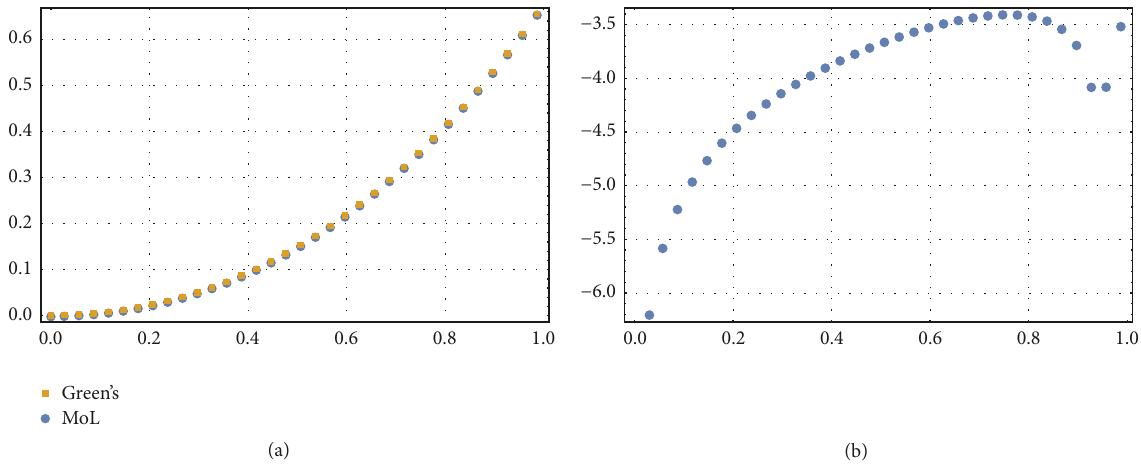
Figure 10: Discrete plot of 𝑤 and 𝑤 MoL (a) and Er (b) against 𝑡 ∈ [0,1] for 𝑓(𝑡) = exp (𝑡) : hyperbolic potential. Green’s